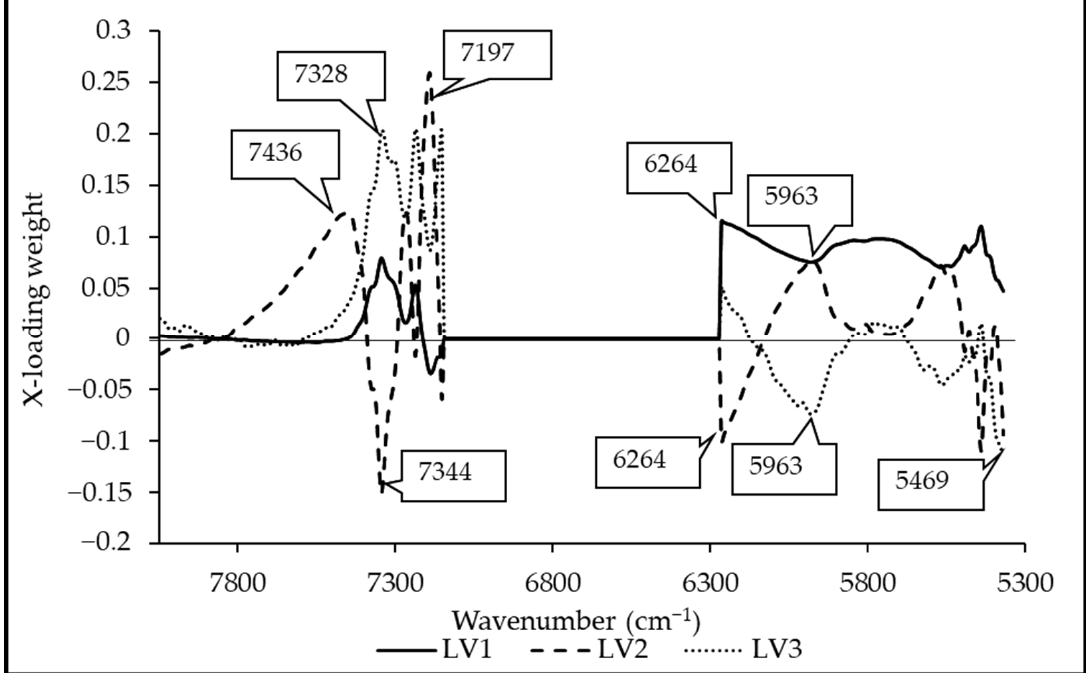
Figure 5. X ‐ loading plot of the PLSR model for TSS prediction in mango purée.